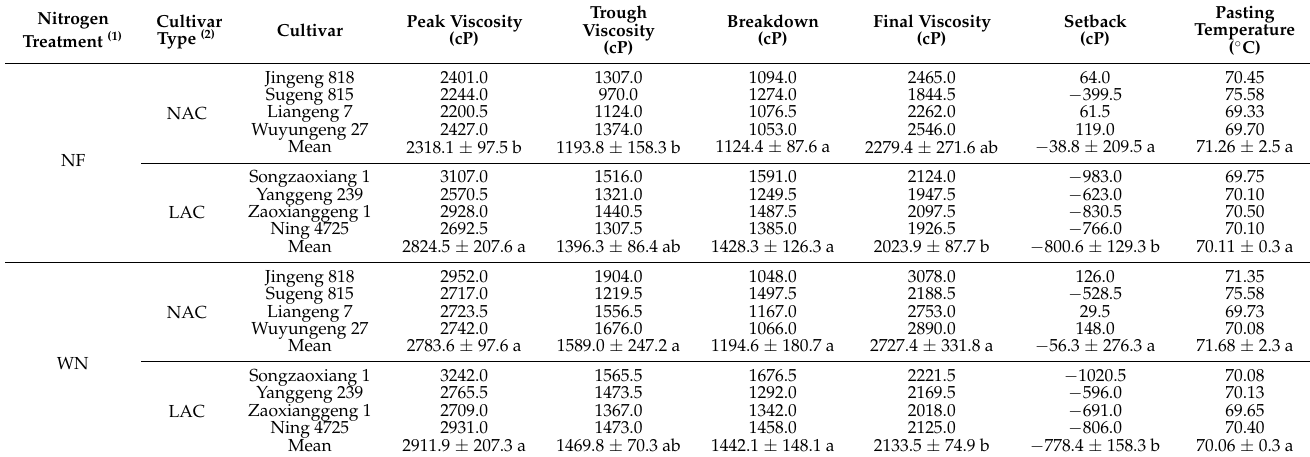
Table 6. Pasting properties of japonica rice cultivars with different contents of amylose, grown with or without nitrogen fertilizer. Nitrogen Treatment